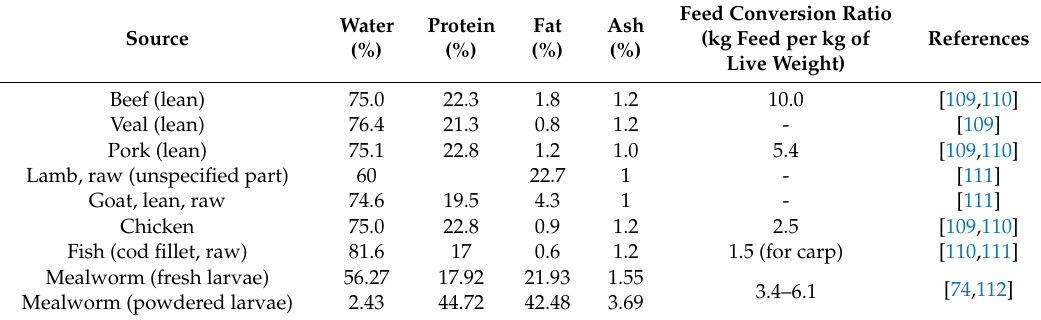
Table 2. Nutritional value of conventional meat and yellow mealworm ( Tenebrio molitor ) (on a fresh matter basis).